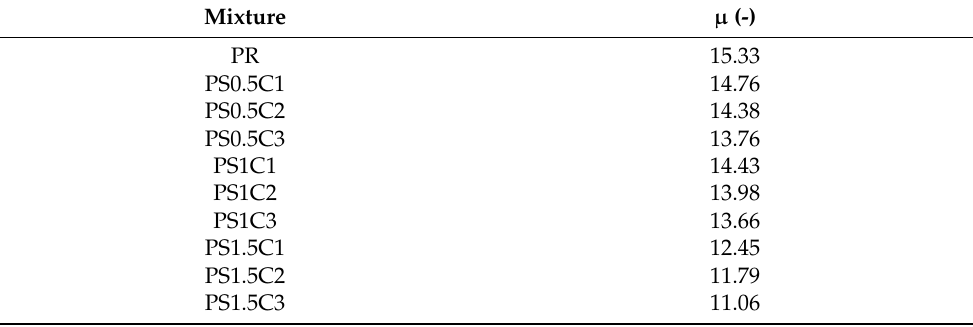
Table 4. Water vapor resistance